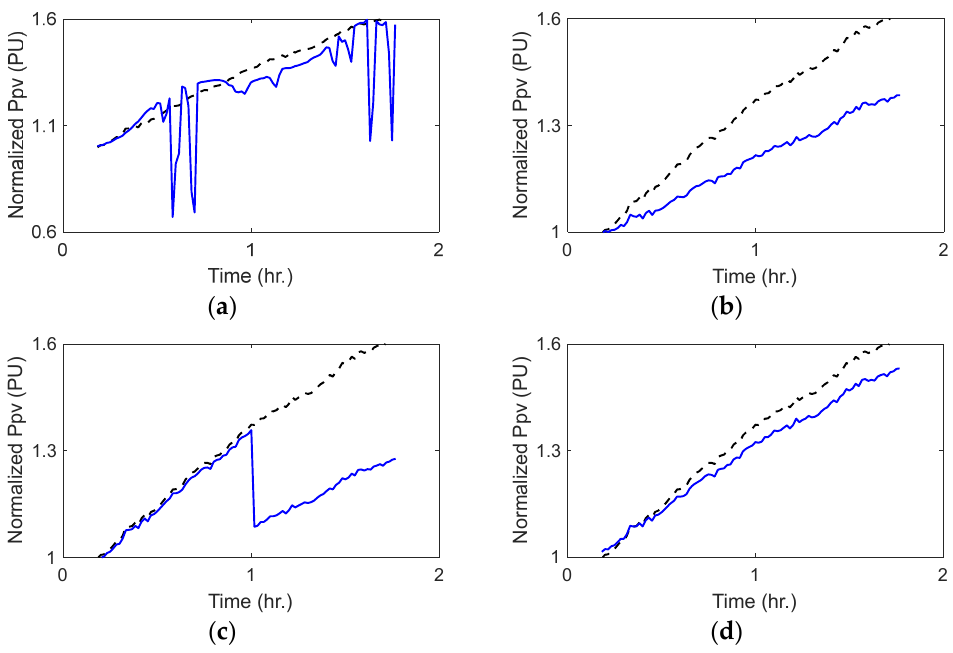
Figure 10. Different case scenarios of the PV output power pattern where (dotted-black line) for estimated power, while (solid-blue line) for actual PV power: ( a ) during cloudy weather; ( b ) with shading impact; ( c ) with a failure in PV panels; ( d ) with an accumulating dust.